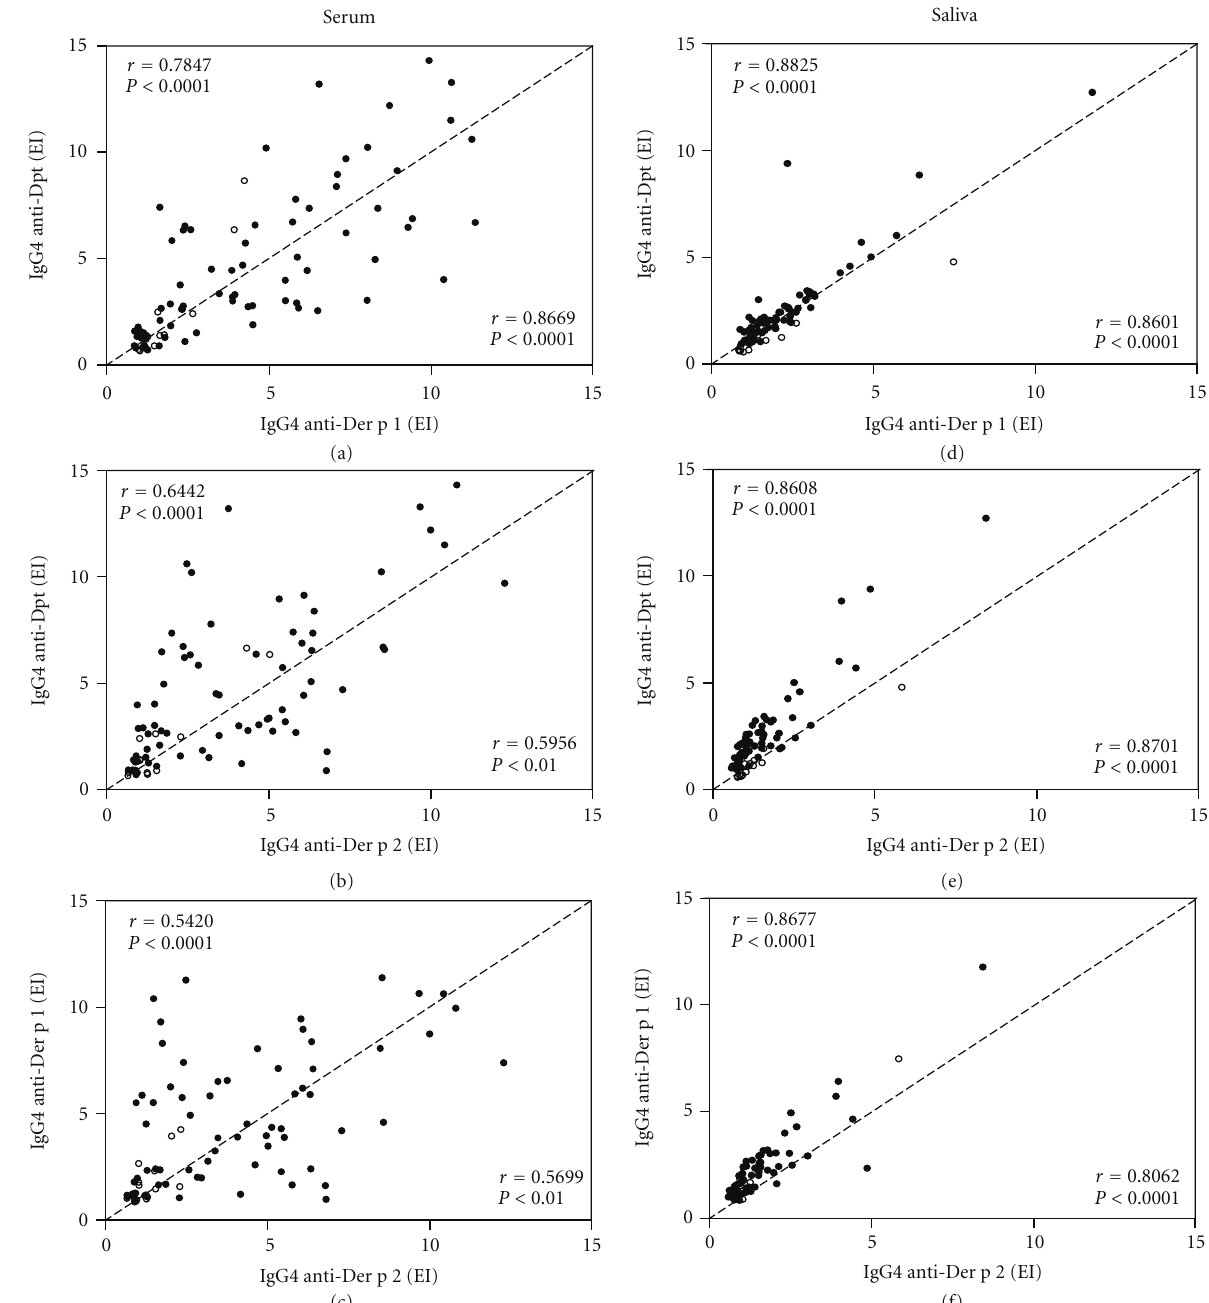
Figure 6: Correlation between levels of IgG4 antibodies to Dermatophagoides pteronyssinus (Dpt) crude extract and its major allergens (Der p1 and Der p2) in serum (a–c) and saliva (d–f ) samples from 72 allergic ( • ) and 14 nonallergic ( ◦ ) infants. Data are expressed in ELISA index (EI) and the dashed line indicates a perfect correlation. The Spearman correlation coe ffi cients ( r ) and statistical significance are also indicated for allergic (on the upper left corner) and nonallergic (on the lower right corner) subjects.